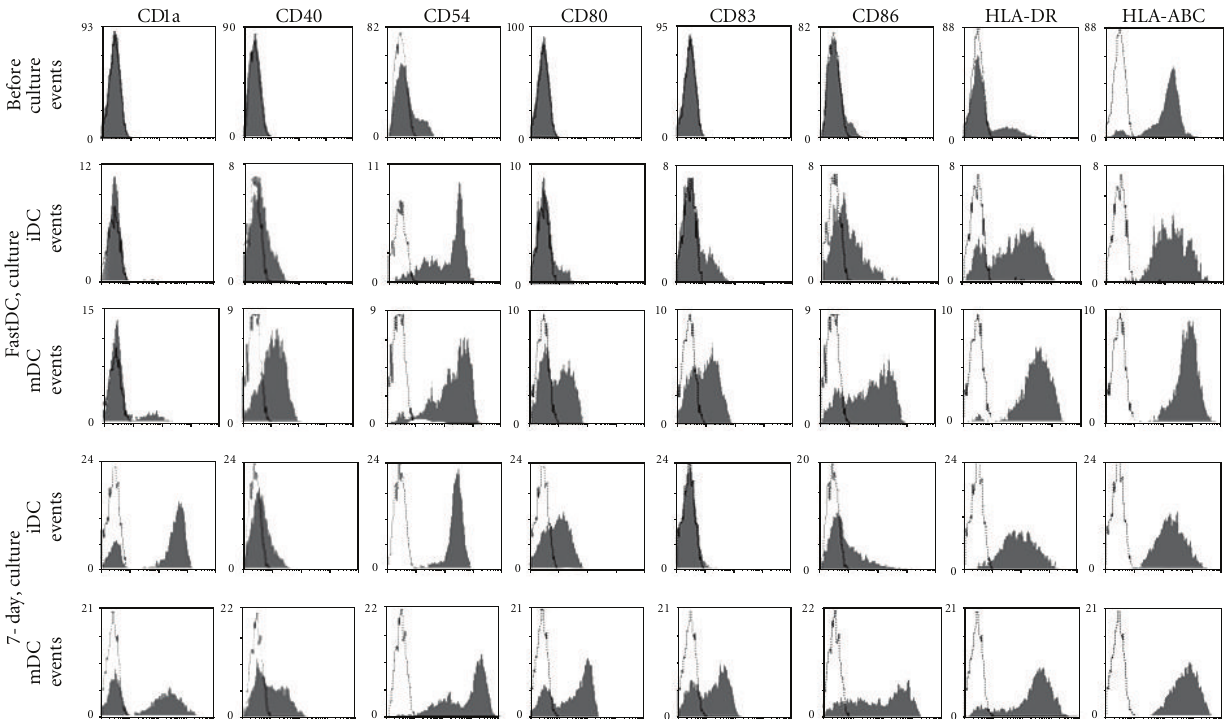
Figure 3: Flow cytometric analyses of iDC and mDC generated from PBMC of the same donor using the FastDC and 7-day culture methods. PBMC freshly prepared from one donor were analysed before culture and then were cultured for DC generation using both the FastDC and 7-day methods. In FastDC culture cells were cultured in IL-4 and GM-CSF for first 24 hrs followed by another 24hrs to mature DC in TNF- α , IL-1 β , IL-6, and PGE 2 . In 7-day culture, PBMC were stimulated in IL-4 and GM-CSF at iDC stage for 5 days then with TNF- α for 2 days to obtain mDC. Data are representative of at least three samples. Unshaded histograms drawn with broken lines are isotype controls and shaded histograms represent marker